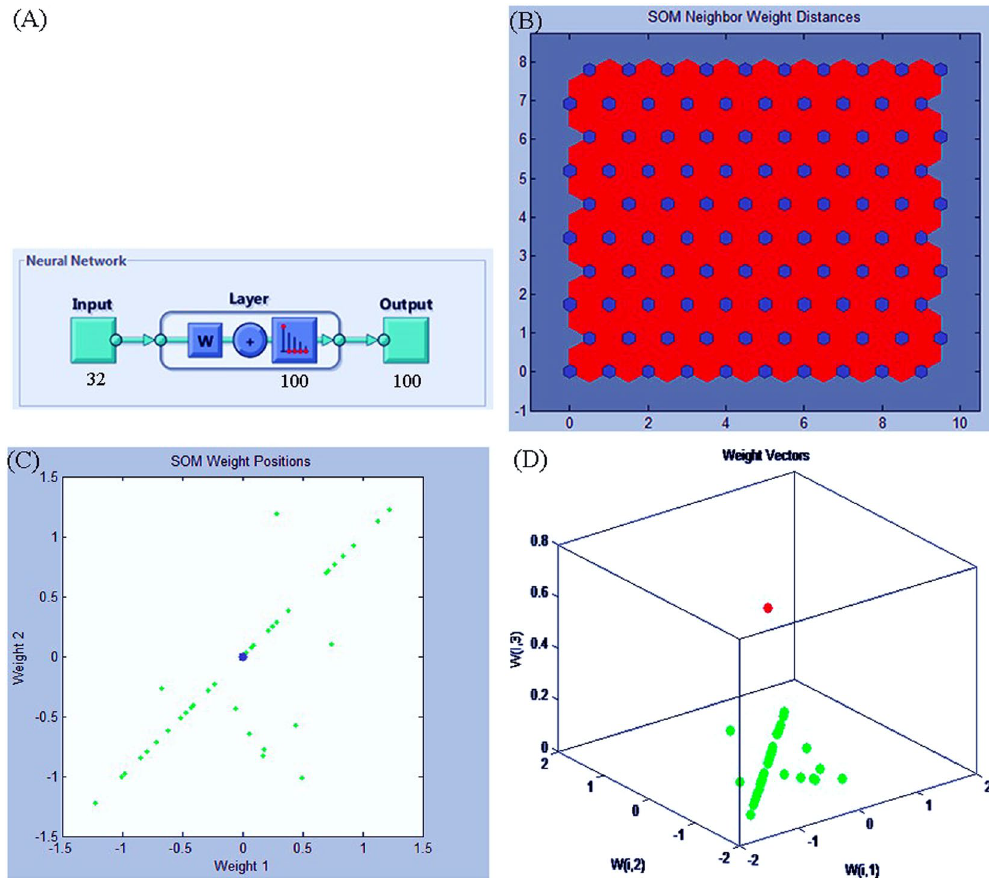
Figure 5. Trained classification structure model ( A ) and weight structure ( B , C and D ) of the SOM neural network. We converted the 46 morphological characters into normalized vectors of codon usage x( t ), and 32 accessions were classified by character factors. Symmetrical effects and differences among the samples are more obvious and significant, although off-diagonal weight points are